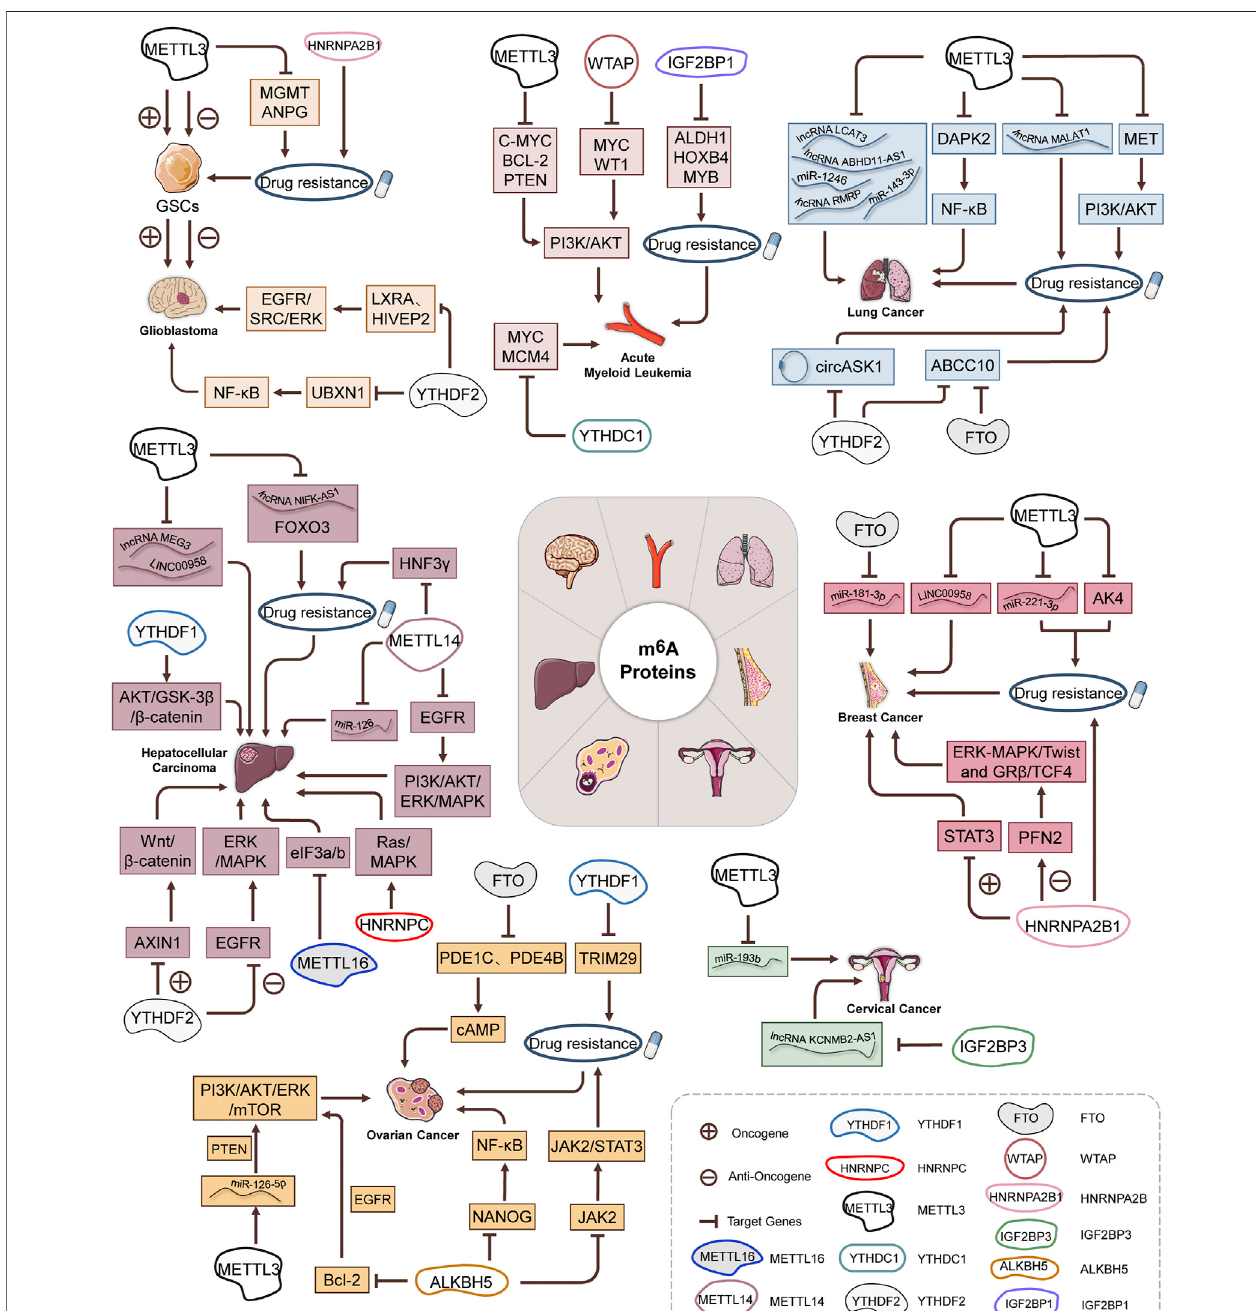
FIGURE 2 | M 6 A RNA methylation steers RNA regulation in cancer